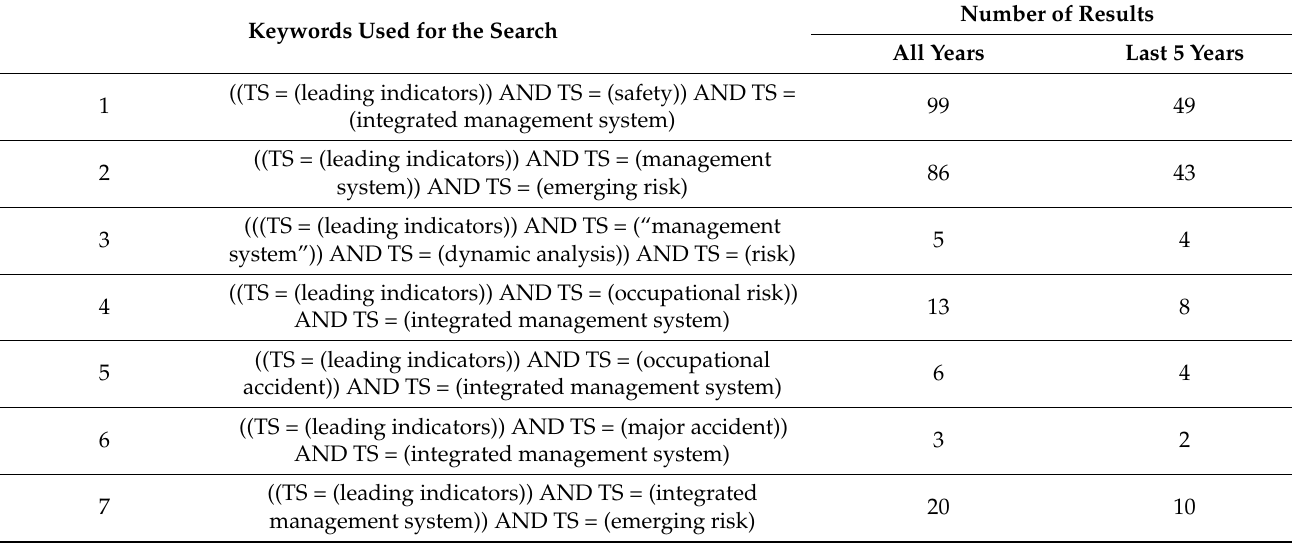
Table 1. Keywords used for the search (Results from the Web of Science; Field tag: topic; All Databases; All years). Keywords Used for the